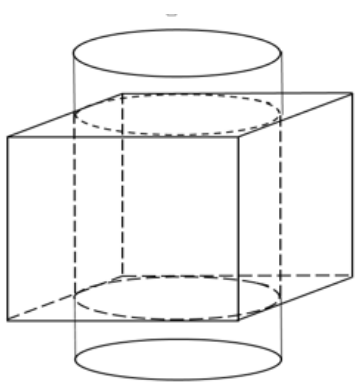
Figure 1. The illustration of the ERT visualization domain within the cylinder tank: the cube indicates the domain has been defined (Jacobian calculation) in this test, where the height of the cube is the distance that will be used for calculating the inclusion moving speed.